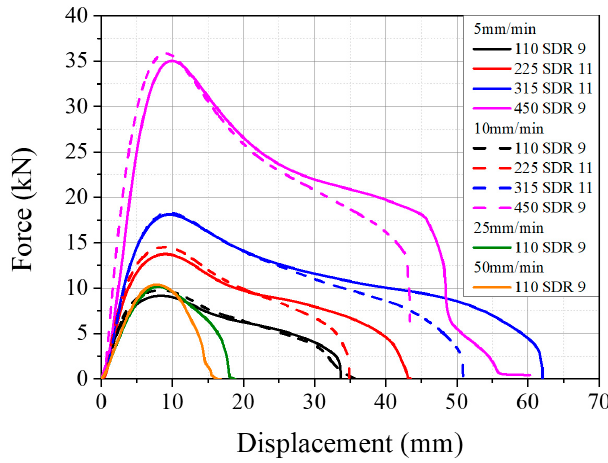
Figure 10. Effect of crosshead speed on load–displacement behavior of TWT specimens.